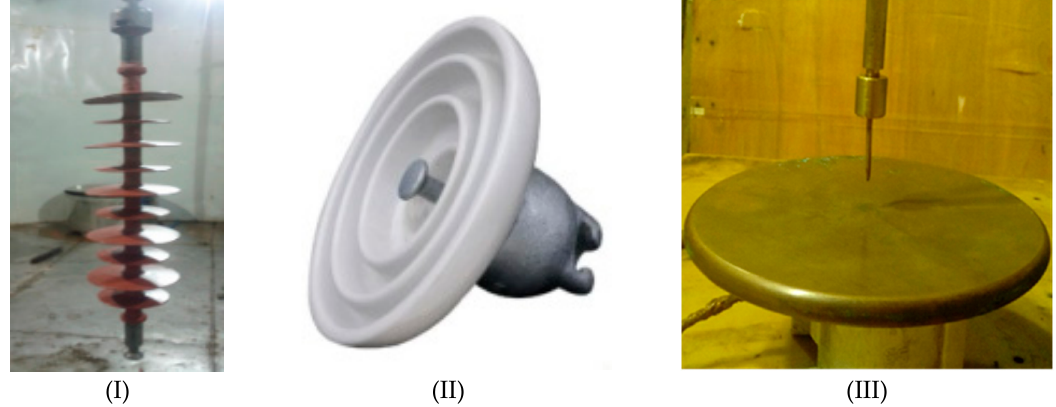
Figure 5. Experimental specimens. ( I ) FXBW ‐ 35/70; ( II ) XP ‐ 70; ( III ) needle ‐ plane model.